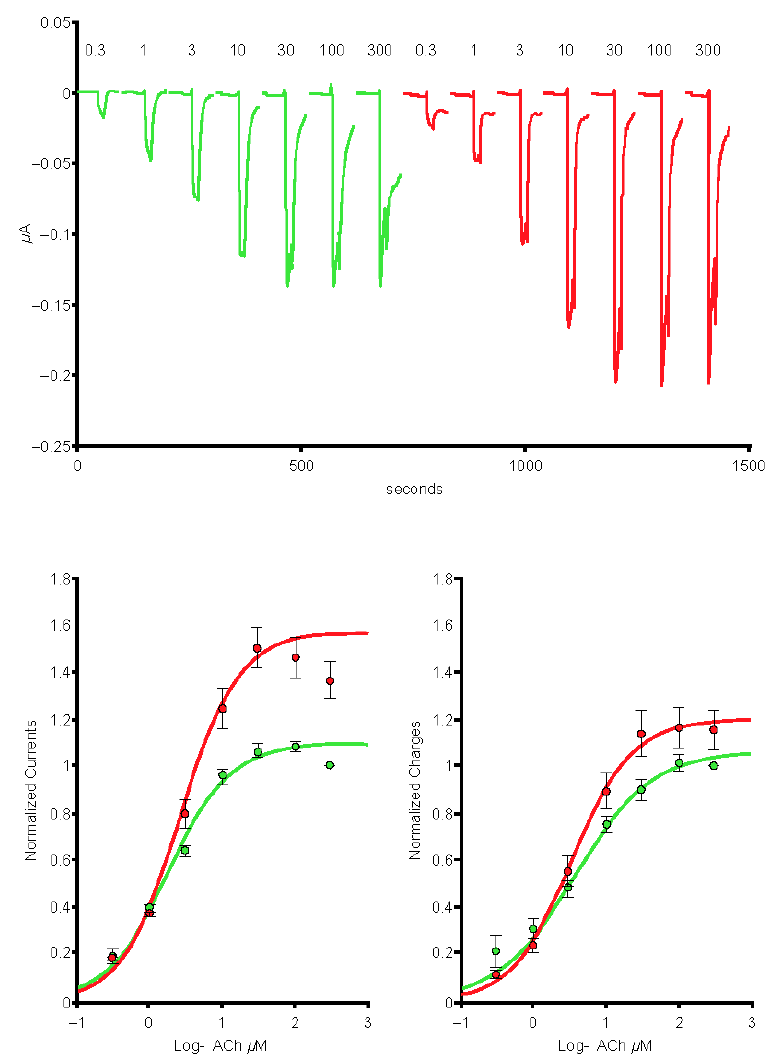
Figure 6. Effects of the severe acute respiratory syndrome coronavirus-2 (SARS-CoV-2) B.1.1.529 spike protein containing the receptor-binding domain (Spike-RBD) protein at the human α 4 β 2 nicotinic acetylcholine receptor. Typical currents were recorded in the same cell before (green traces) and during exposure to 10 µg/mL of the SARS-CoV-2 B.1.1.529 Spike-RBD protein (red traces). Currents were elicited by brief exposure to acetylcholine (ACh) test pulses with a series of concentrations. Currents were normalized to unity vs. the maximal value and average results obtained in five cells were plotted vs. the logarithm (log) of the ACh concentration. The green curve is the best fit obtained with the Hill equation. Areas under the curve are plotted on the lower right- hand side.